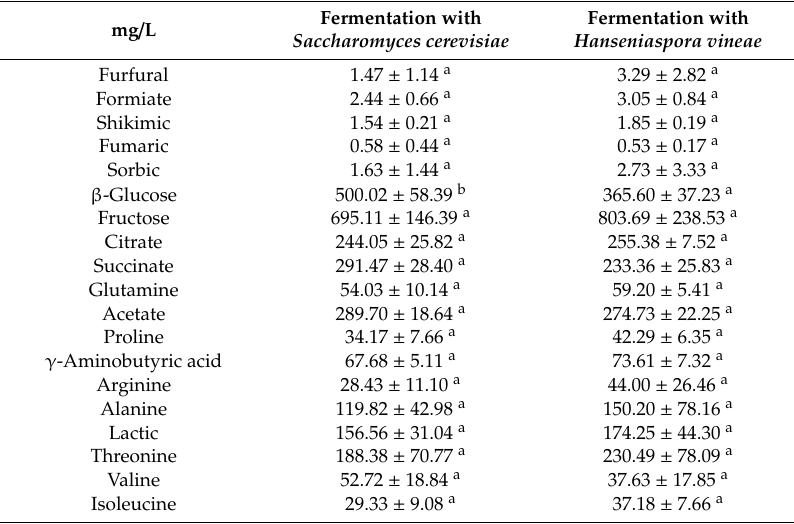
Table 1. Targeted metabolites concentration (mg / L) of Saccharomyces cerevisiae and Hanseniaspora vineae wine samples obtained with the PULCON-NMR method